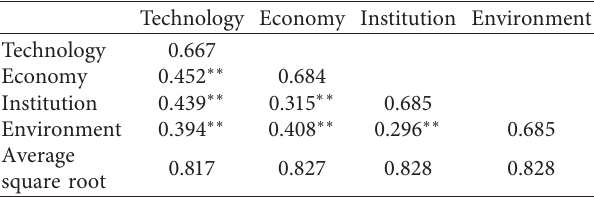
Table 10: Differential validity